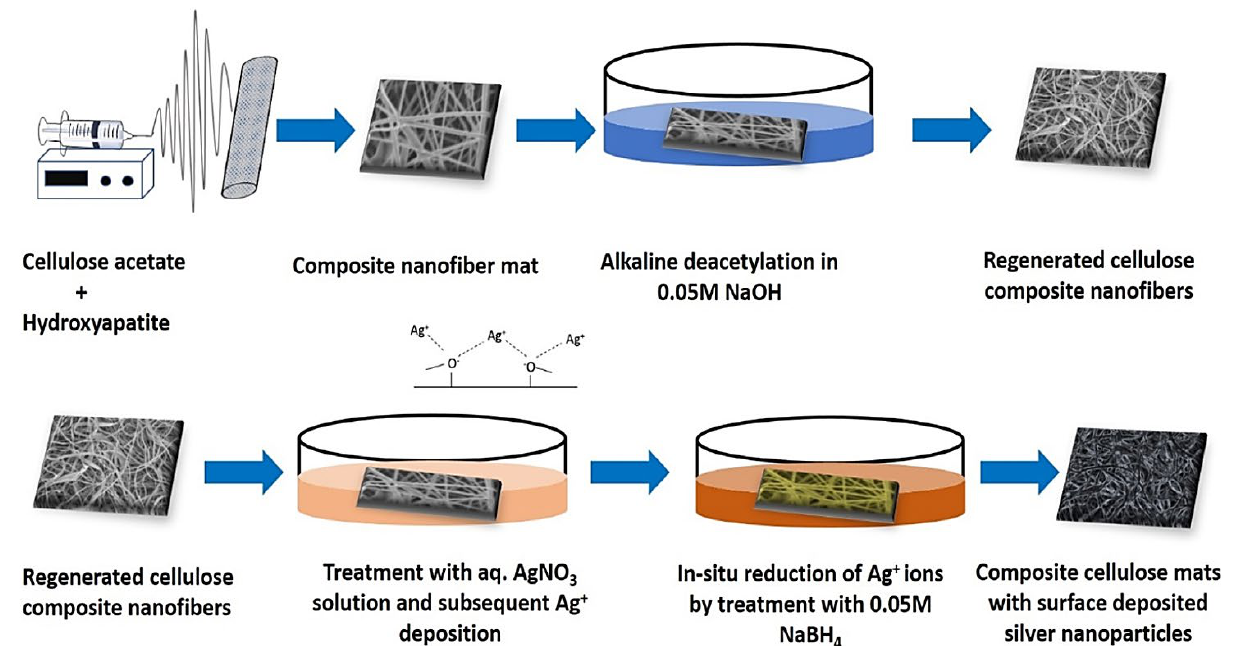
Figure 3. The preparative process of regenerated cellulose nanofibers from cellulose acetate and incorporation of hydroxyapatite and silver (Ag) nanoparticles in designing tissue engineering scaffolds. Adapted from reference [77] with permission. Copyright 2020 Elsevier.